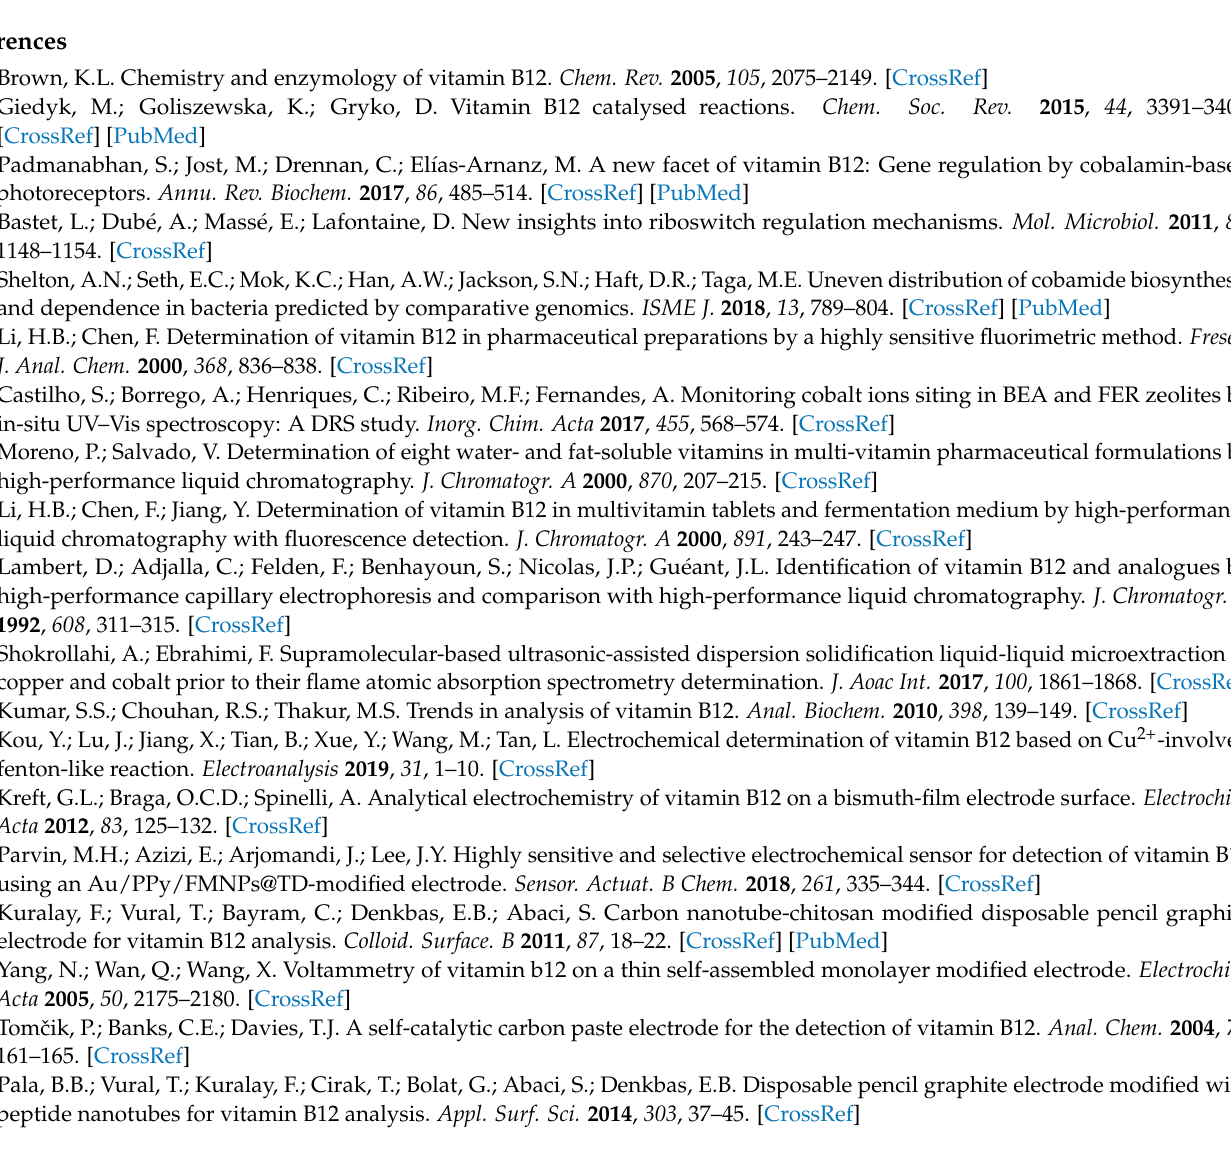
.3390/w13131790/s1, Figure S1: Absorption spectra of VB12, oxidized VB12 and potassium nitrate, Figure S2: Oxidation efficiency of VB12, Figure S3: I-t curves of VB12 with different concentrations in the range of 0.2-1 µ g L − 1 (a), 2-10 µ g L − 1 (c), 0.02-0.10 mg L − 1 (e), 0.2-1.0 mg L − 1 (g), 2-10 mg L − 1 (i) at − 1.36 V and (b, d, f, h, and j) corresponding calibration plots, Figure S4: Effect of polarization time on the removal ratio of metal ions at − 0.5